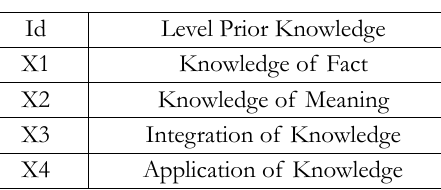
Table 3. Level prior knowledge